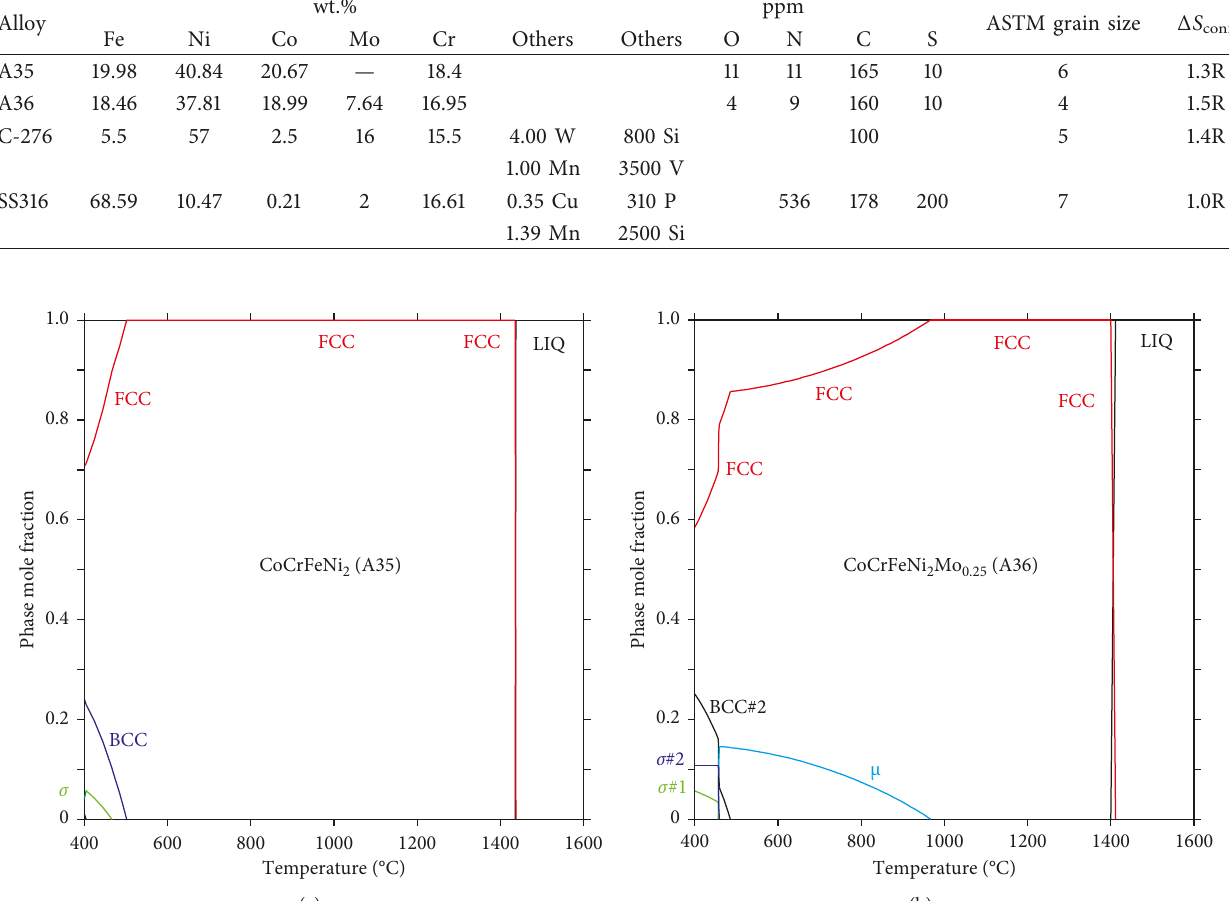
2 (A35) and (b) CoCrFeNi 2 Mo 0.25 (A36) alloys